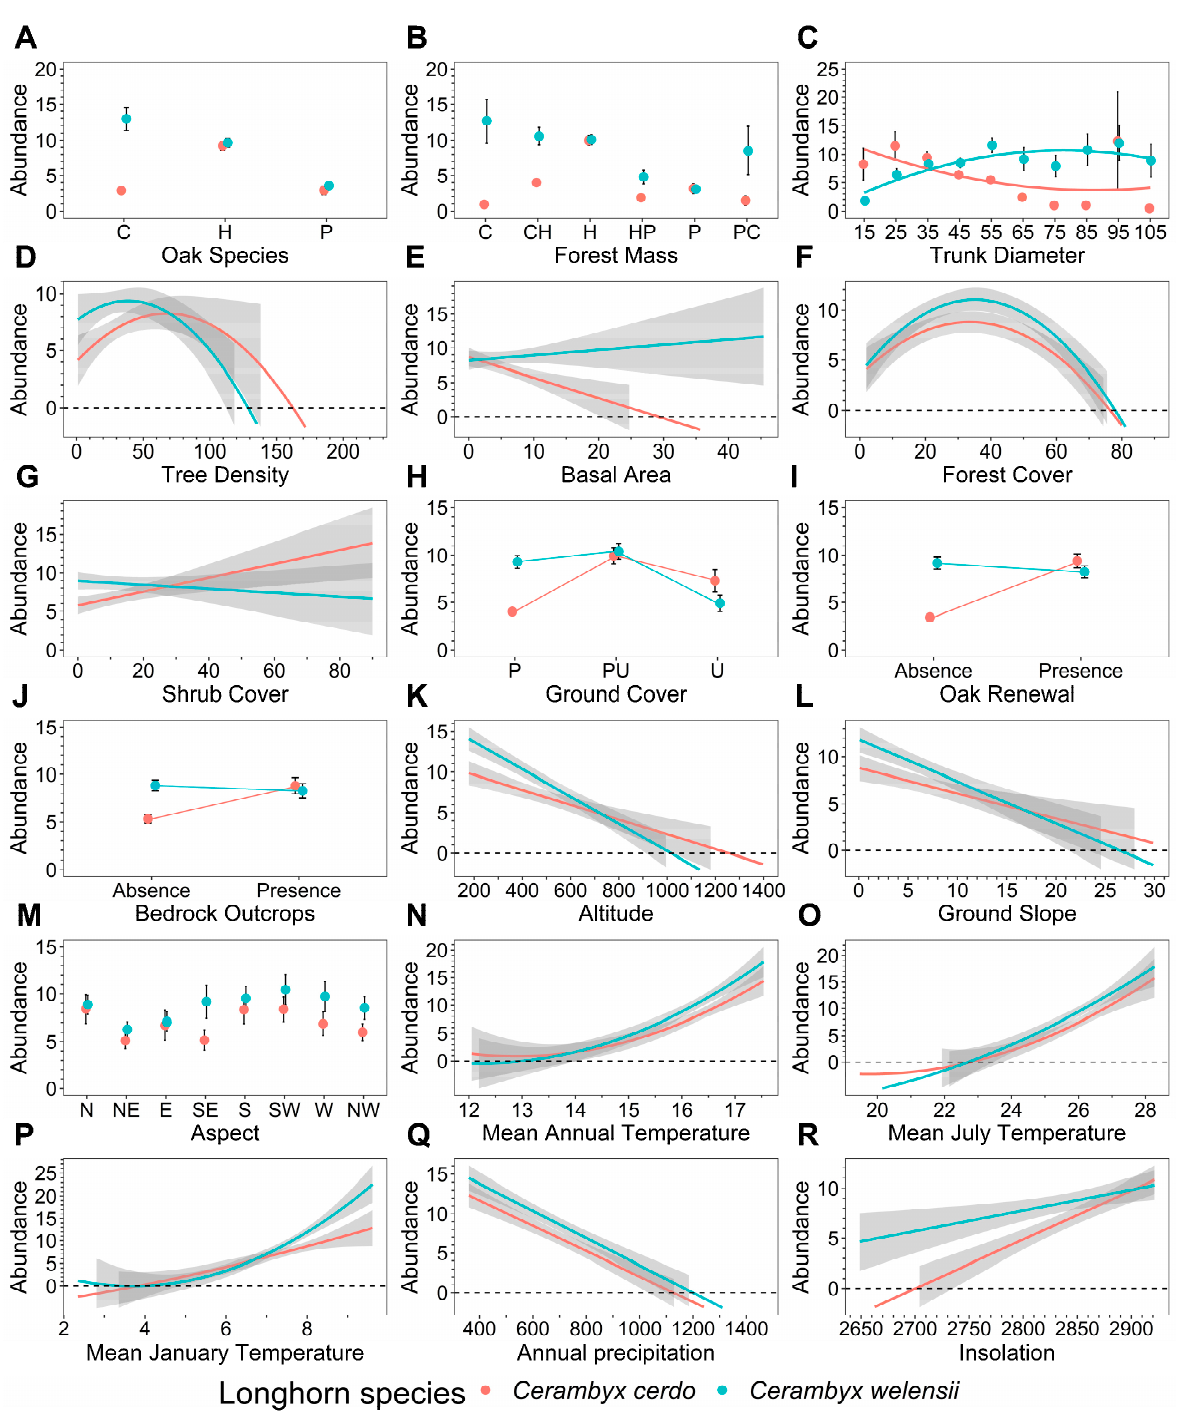
Figure 1. Effects of each of the 18 ecological variables studied on the abundance (adult catches per trap per year) of Cerambyx cerdo and Cerambyx welensii . ( A ): Oak species, ( B ): Forest Mass, ( C ): Trunk Diameter, ( D ): Tree Density, ( E ): Basal Area, ( F ): Forest Cover, ( G ): Shrub Cover, ( H ): Ground Cover, ( I ): Oak Renewal, ( J ): Bedrock Outcrops, ( K ): Altitude, ( L ): Ground Slope, ( M ): Aspect, ( N ): Mean Annual Temperature, ( O ): Mean July Temperature, ( P ): Mean January Temperature, ( Q ): Annual Precipitation, ( R ): Insolation. Vertical lines represent the standard error of the mean (SEM) and gray shaded areas the confidence intervals (95%) for categorical and quantitative predictor variables, respectively. See Table 2 and text for a detailed statistical analysis through GLMMs.